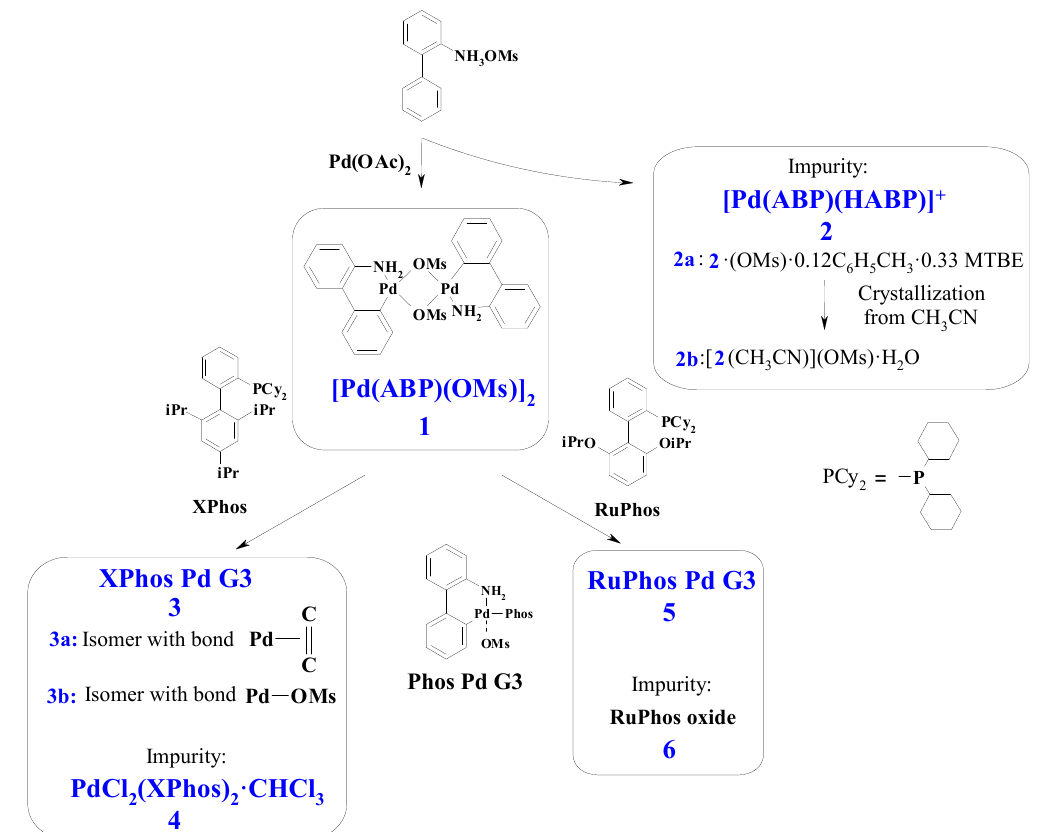
Figure 1. General scheme for synthesis of Buchwald G3 precatalysts and other compounds considered in this paper. Only distinctive features of 3a and 3b are indicated on the scheme. Phos Pd G3 is the general formula for the complexes 3 and 5 (for 3 Phos = Xphos, for 5 Phos = RuPhos). See text for details.